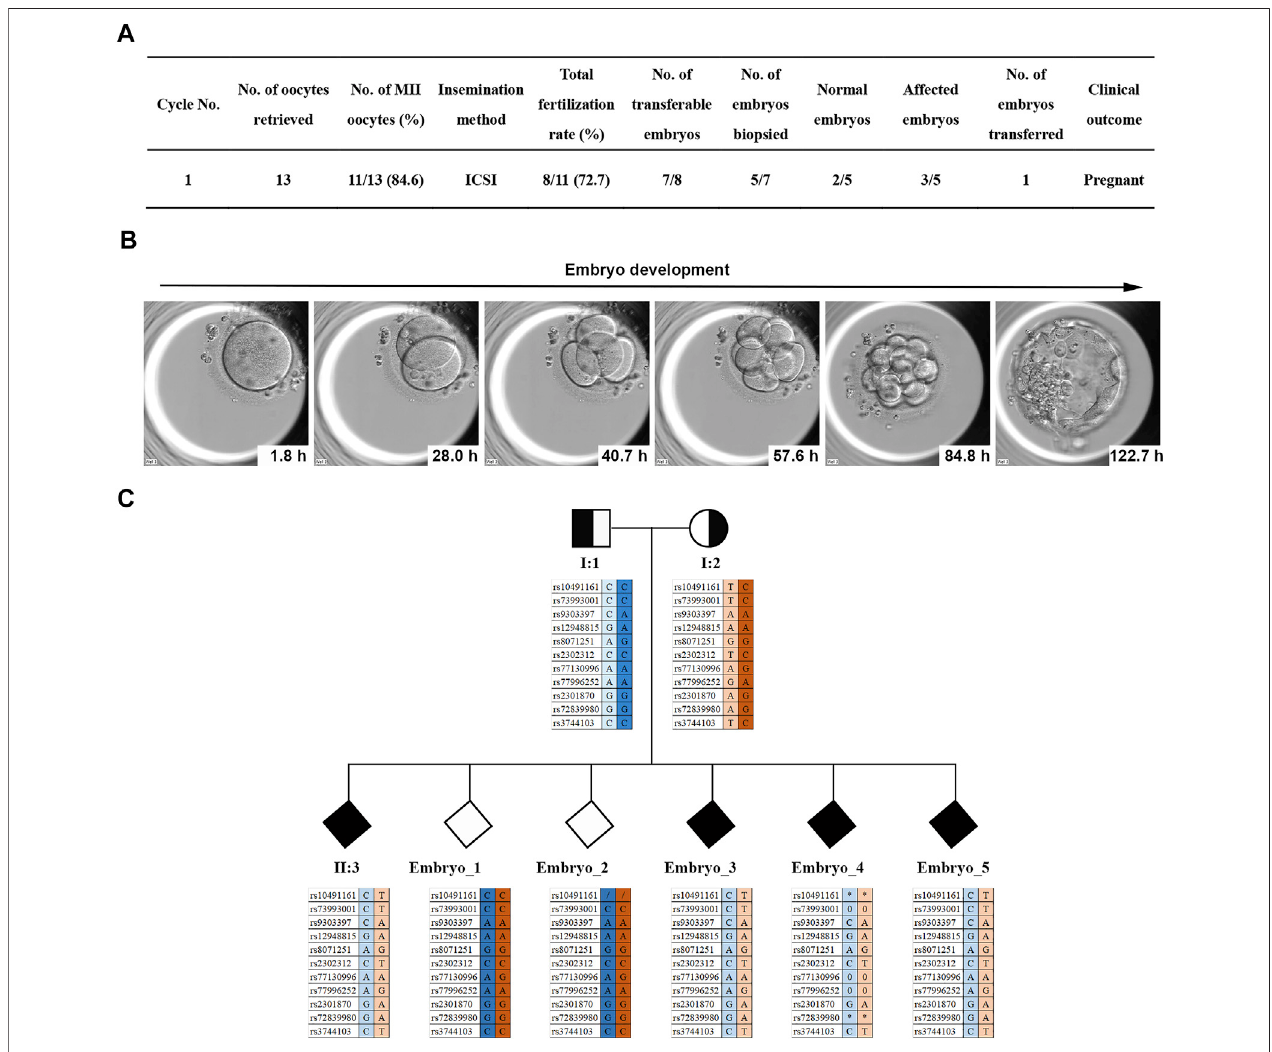
FIGURE4| PGTforthetwo MKS1 variants. (A) StatisticaldataoftheARTandPGT-McyclesoftheMKS-relatedcouple. (B) Theimagesof invitro earlyembryonic development. (C) Results of haplotype linkage analysis. Based on the genotype of the SNP locus of the aborted fetus II:3, embryos carrying the MKS1 gene mutations were deduced: unknown gender without MKS1 mutations; unknown gender with MKS1